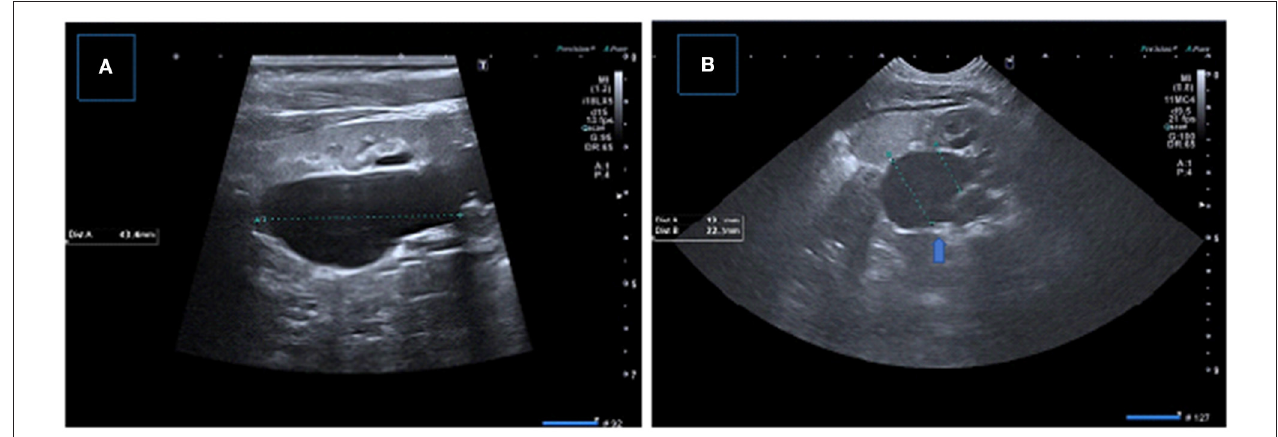
FIGURE 4 | Incorrect measurement of APRPD in longitudinal (A) and transverse (B) US images showing incorrect measurement at extrarenal level (arrow), correct measurement level is also